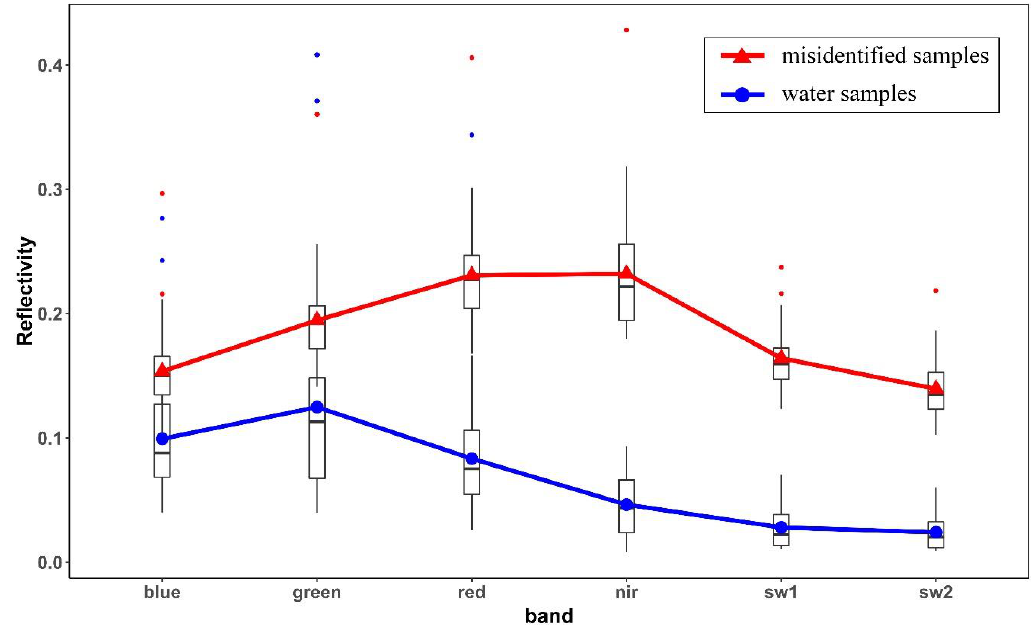
Figure 3. Spectra of water samples and misidentified samples. Table 1. Water index list.